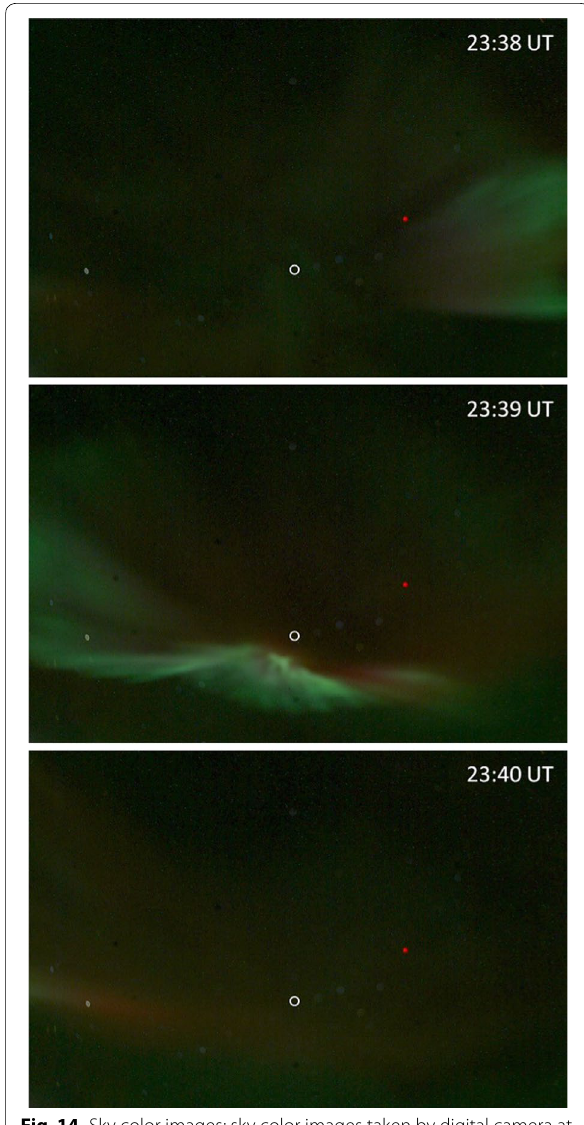
Fig. 14 Sky color images; sky color images taken by digital camera at 23:38 UT ( top ), 23:39 UT ( middle ), and 23:40 UT ( bottom ) on October 11,